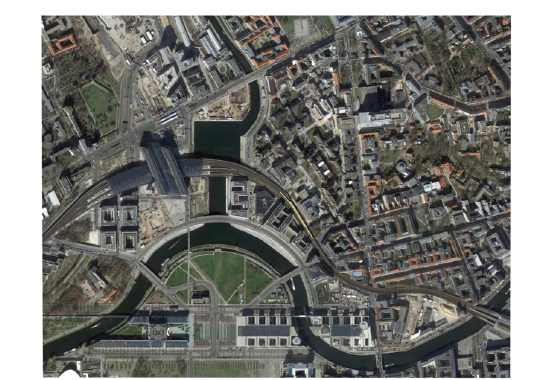
Figure 6. The common region of interest, in Berlin, Germany from which TerraSAR-X and UltraCam image patches were cut to generate the the SARptical dataset [17].